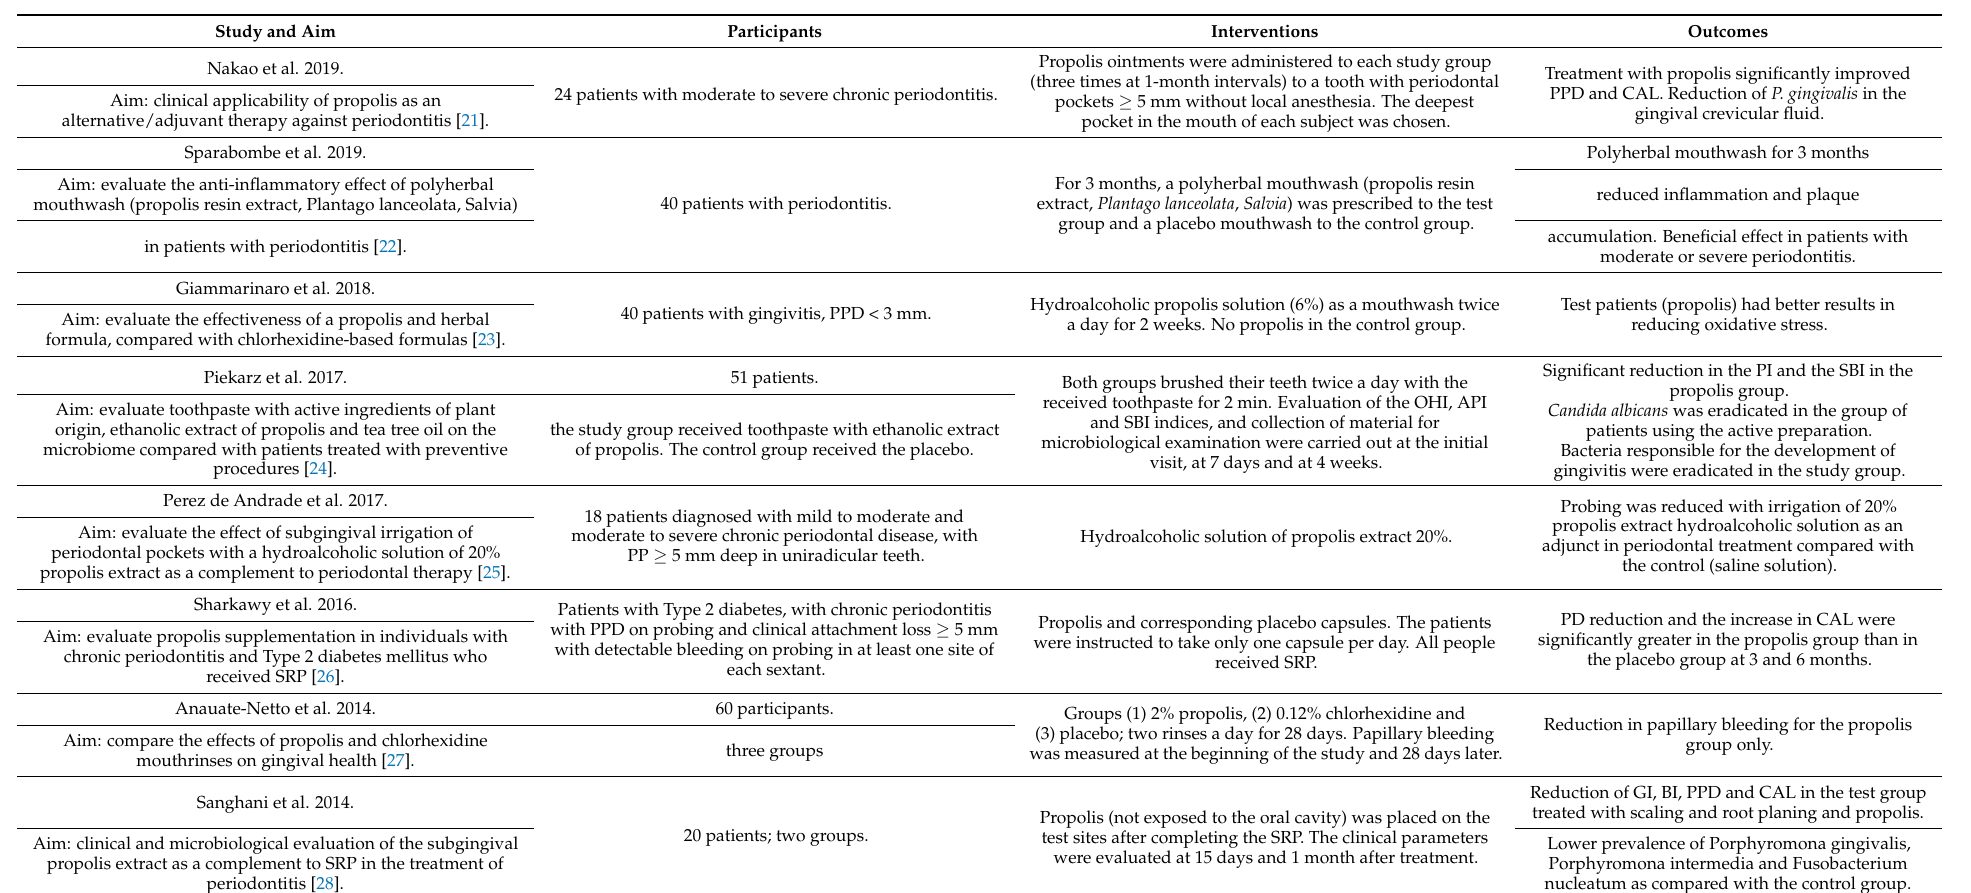
Table 2. Characteristics of randomized clinical